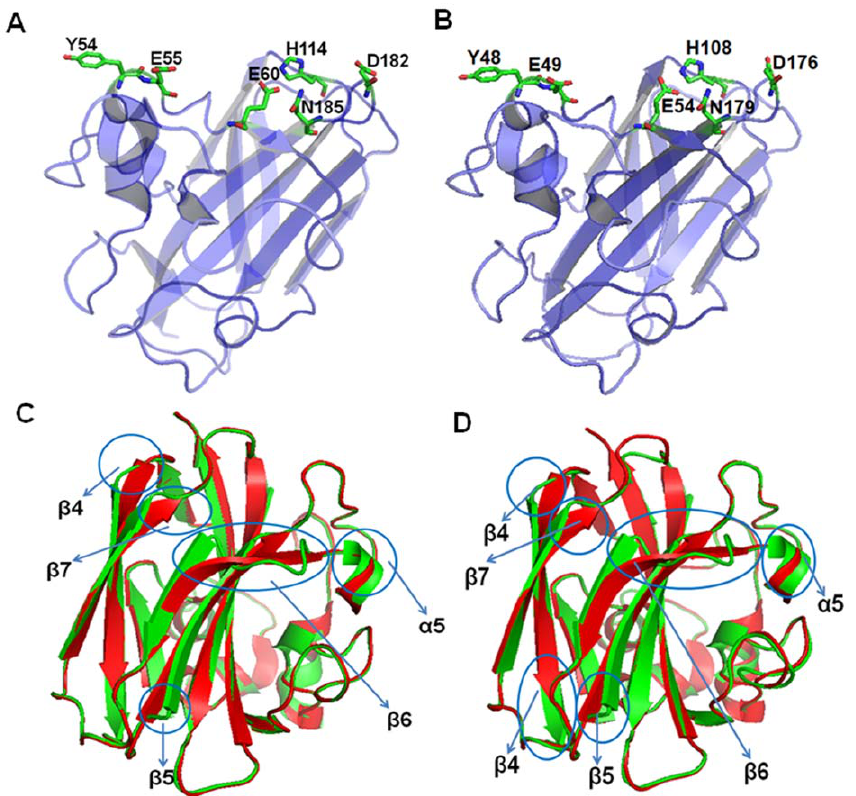
Figure 4. The 3D models of Sp CBP21 and Sp CBP50. (A and B) The models Sp CBP21 and ChBD region of Sp CBP50 were generated by Modeller9v8 (http://www.salilab.org/modeller/) using Sm CBP21 (PDB ID: 2BEM) as structure template. Residues important for chitin binding were shown in sticks representation with carbon, oxygen and nitrogen atoms colored light green, red and dark blue, respectively. The figures were prepared using PyMOL (http://www.pymol.org/), (C and D) Stereo view of the superimposed structure of Sp CBP21 and Sp CBP50 (green) with Sm CBP21 (red), respectively.